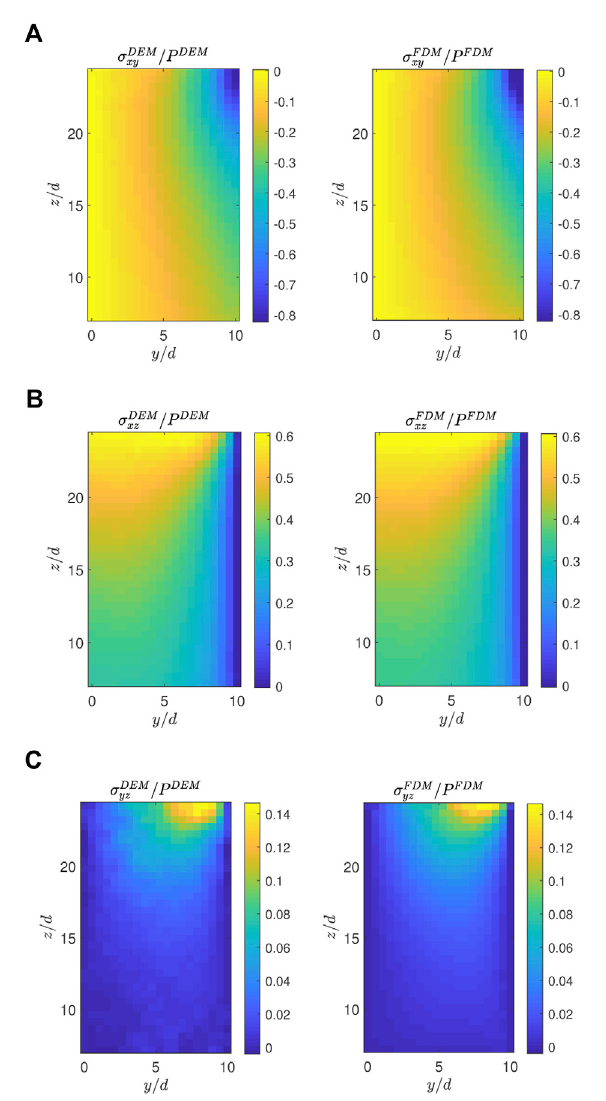
FIGURE 14 Comparison of off-diagonal stress maps between the DEM simulation (left) and the FDM simulation using the second-order model (right) with tan θ =0.60: (A) σ xy / P , (B) σ xz / P , and (C) σ yz / P